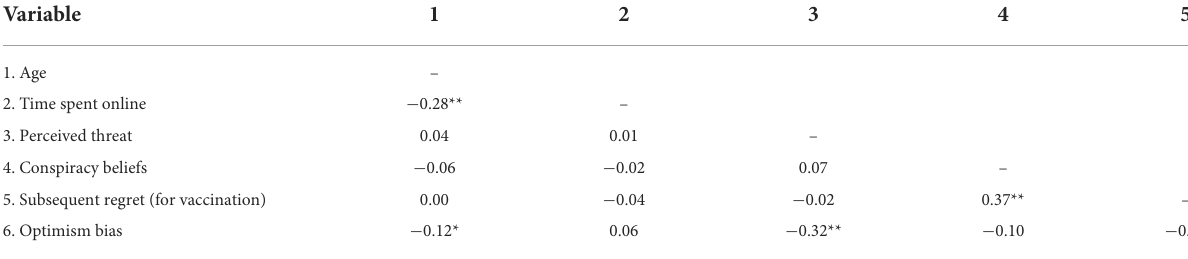
TABLE 2d Associations between the main variables ( N = 270, participants who were already vaccinated against COVID-19).